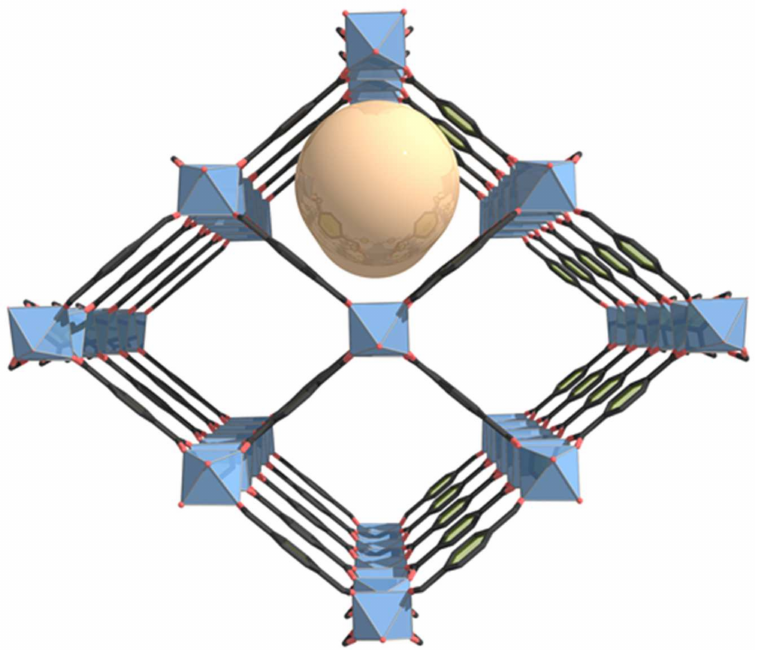
Figure 9. Crystal structure of MIL-47(V) with a view along the chain axis, highlighting the 1D pores system. The blue polyhedra represent the V 4+ O 6 ocahedral shared in the chain. (Red: oxygen, and black: